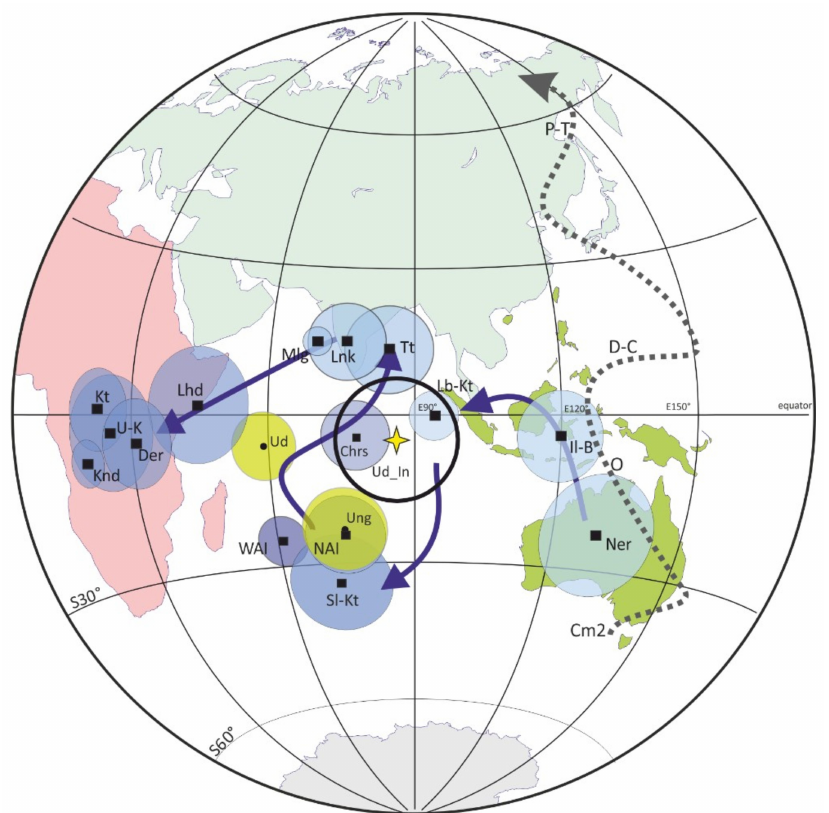
Figure 8. Comparison of the paleomagnetic pole obtained from the mafic intrusions of the Udzha paleo-rift (1386 ± 30 Ma); VGP from the Chieress dyke of the Anabar shield (1384 ± 2 Ma [24]) and other Precambrian Siberian poles. Star—VGP for Udzha’s intrusions at ~1380 Ma. Definitions of the abbreviations are in Table 2. Dotted line shows APWP for Phanerozoic of Siberian craton by [33]; blue arrows—the general trend of Proterozoic Siberian